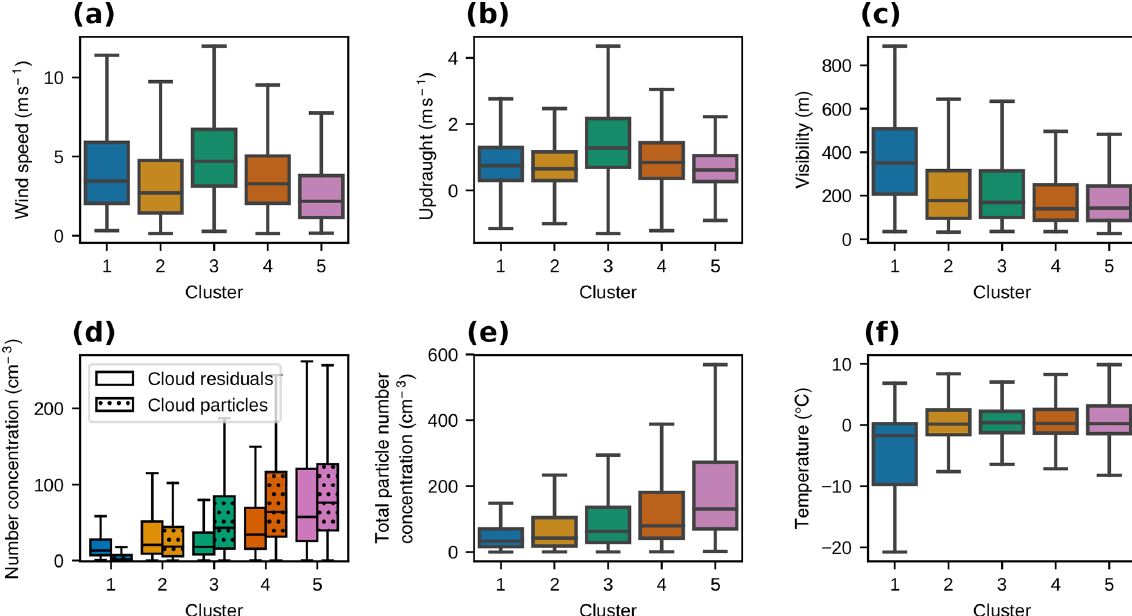
Figure 9. Additional parameters for the cluster analysis from Fig. 8. The panels show the distribution per cluster of (a) wind speed, (b) up- draught, (c) visibility, (d) cloud residual (solid, corrected for GCVI sampling efficiency) and cloud particle (hatched, without any correction factors) number concentrations, (e) total particle number concentration, and (f) temperature. The whiskers of the box plots extend to the farthest points that are within 1.5 times the interquartile range from the nearest quartile. Points that fall outside the whiskers are not shown.